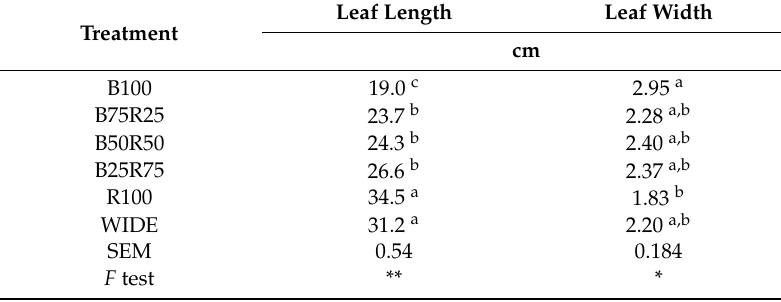
Table 2. Dimensions of the first leaf (cm). SEM: pooled standard error of the mean. * and ** indicate that the values are significantly di ff erent for p < 0.05 and p < 0.01, respectively. Means followed by the same letter are not di ff erent for p < 0.05 (Tukey’s HSD test).